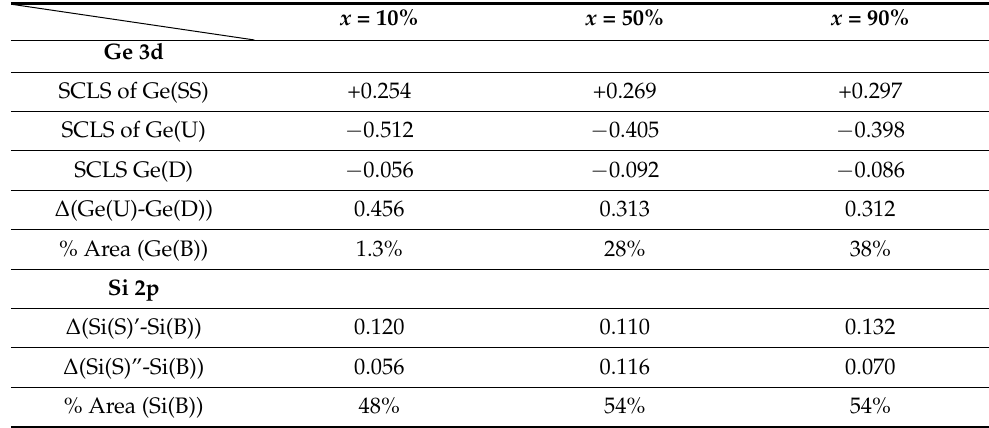
Figure 8. Photoemission data from the as-grown Si 1 − x Ge x (001)-2 × 1 on an Si(001) substrate with Ge contents of 10%, 50%, and 90% for the Ge 3d ( a ) and Si 2p ( b ) core-level spectra. The Ge 3d states of the representative x = 50% sample were acquired at ( c ) various photon energies (h ν ) taken under normal emissions ( θ e = 0 ◦ ) at room temperature, as well as at ( d ) various emission angles at h ν = 80 eV. The Si 2p states of the representative x = 50% sample were acquired at ( e ) various photon energies (h ν ) taken under normal emissions ( θ e = 0 ◦ ) at room temperature, as well as at ( f ) various emission angles at h ν = 136 eV. Panel ( g ) shows the valence band spectra and the cutoffs. Table 3. Fitted parameters of the Ge 3d core-level spectra in Figure